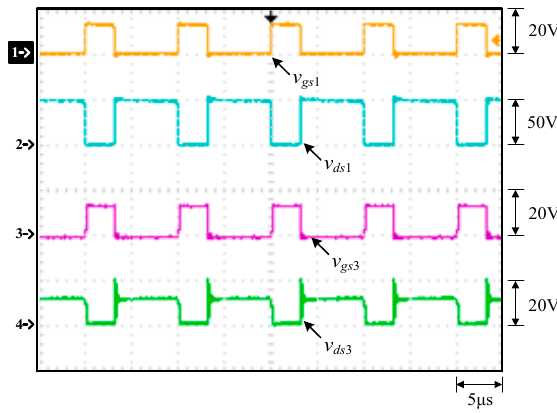
Figure 15. Measured waveforms at rated load: (1) v gs 1 ; (2) v ds 1 ; (3) v gs 3 ; (4) v ds 3.